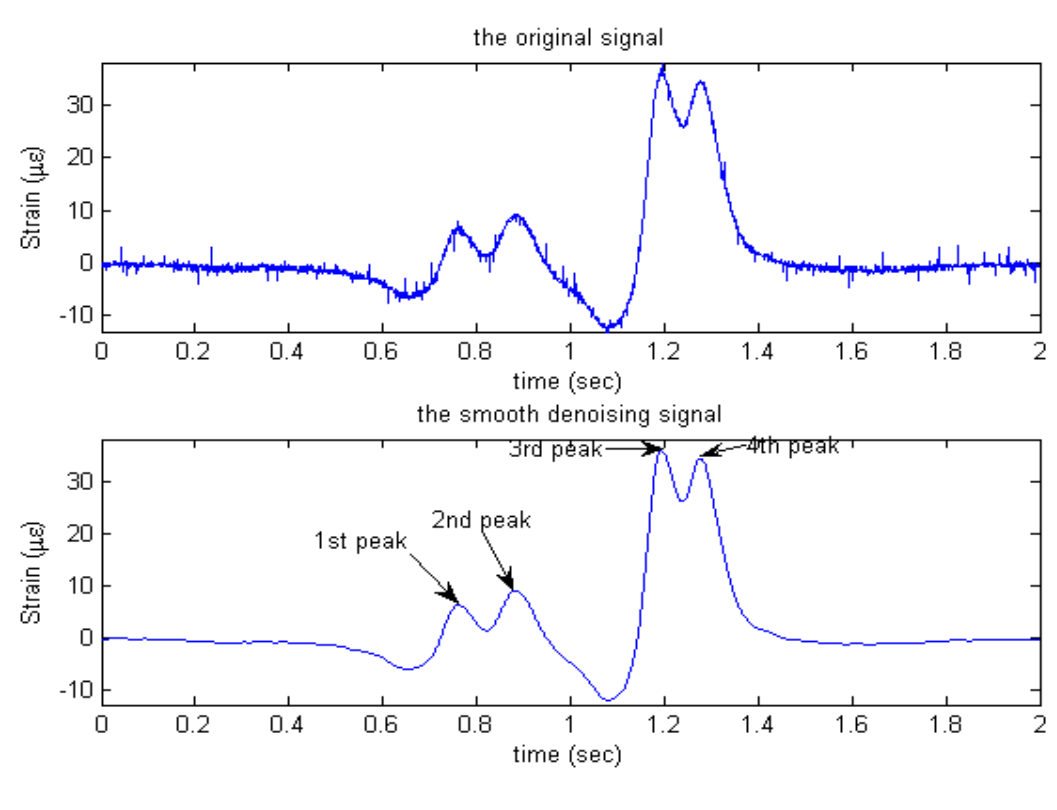
Figure 6. Characteristics of a four axle traffic-induced strain response time history.